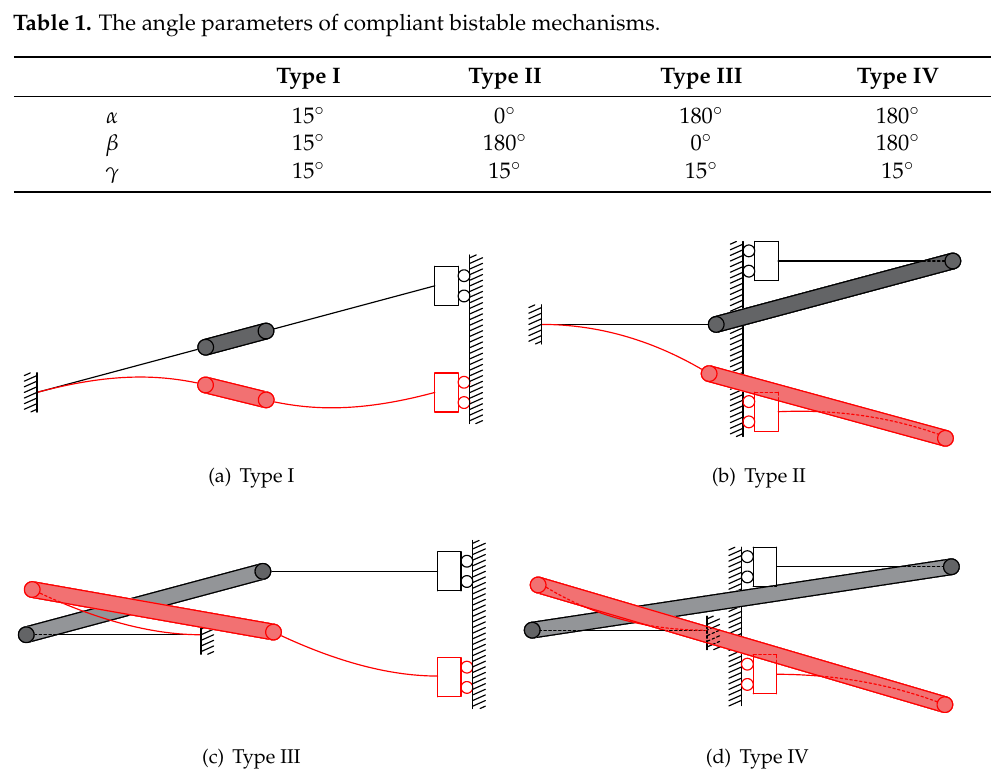
Figure 3. Compliant bistable mechanisms derived from the generalized model when the parameters α and β are set at different angles. These mechanisms are designed based on the multi-layer analysis model. The left half-segments are anchored to the frame, and the right half-segments are connected to the